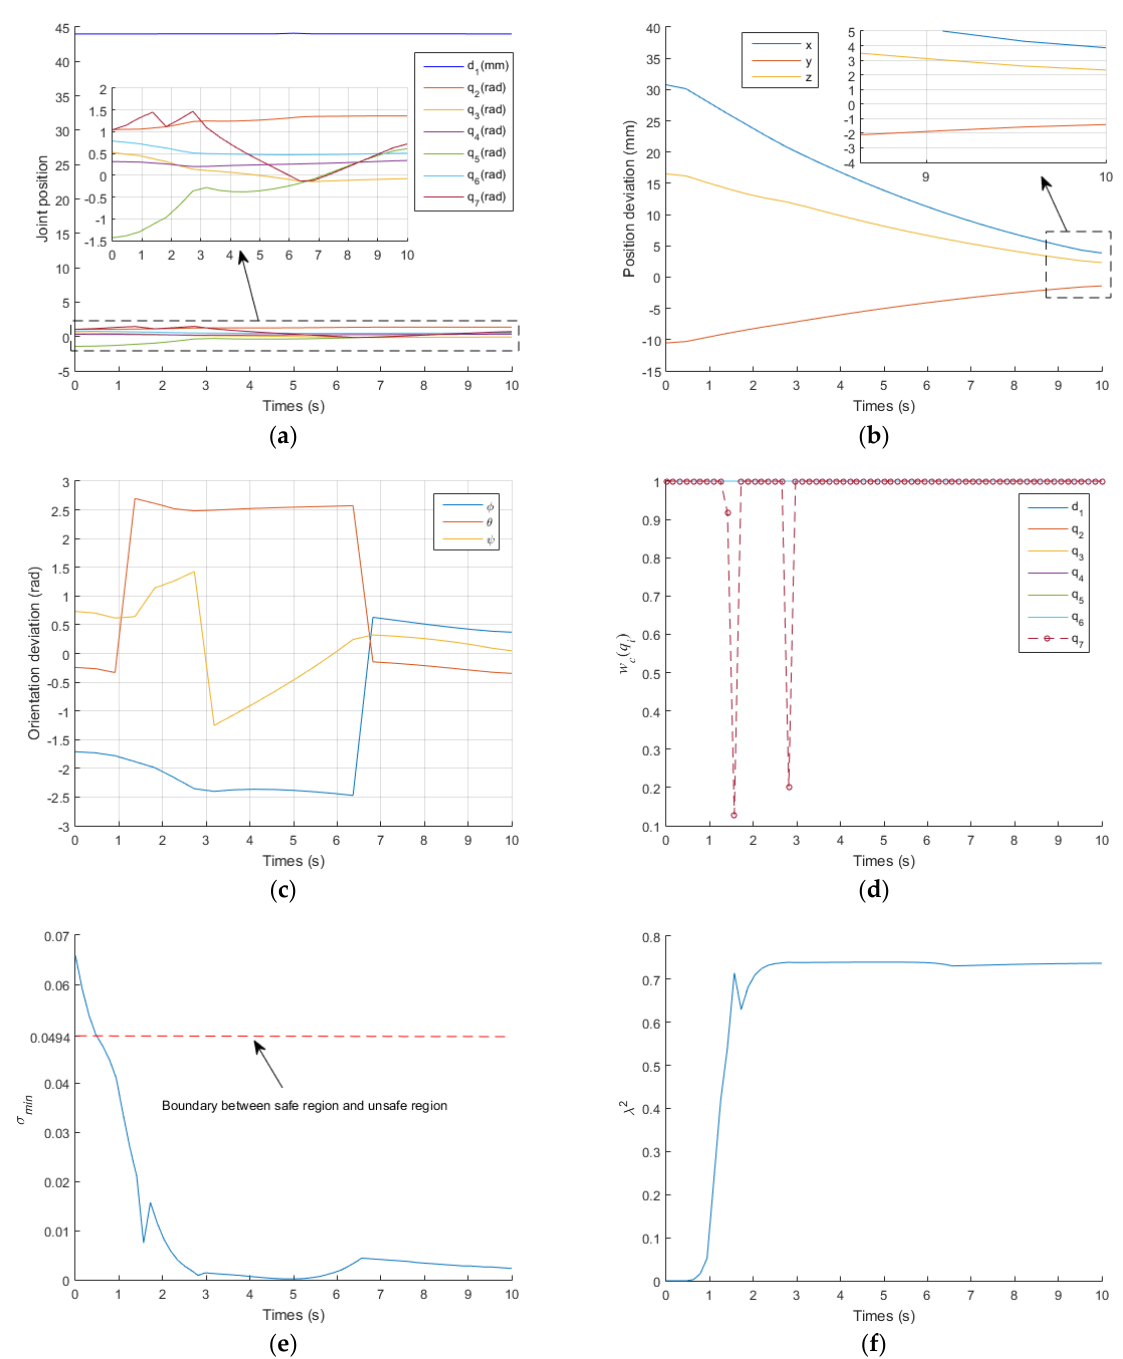
Figure 10. Simulation results of the proposed IWGPM (no singular potential energy function). ( a ) the change curve of joint position; ( b ) the change curve of position deviation; ( c ) the change curve of orientation deviation; ( d ) the change curve of w c ( q i ) ; ( e ) the change curve of σ min ; ( f ) the change curve of λ 2